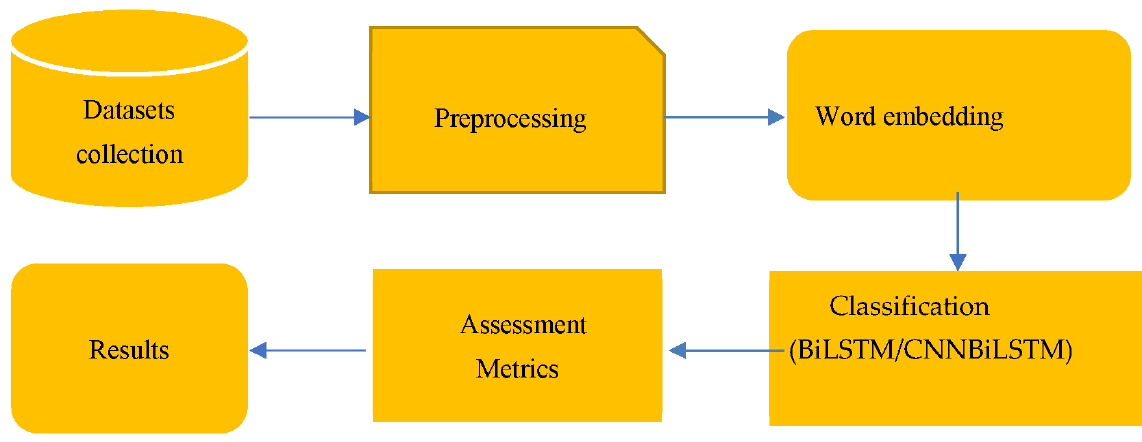
Figure 1. The framework of the applied cyberbullying detection system (CDS).